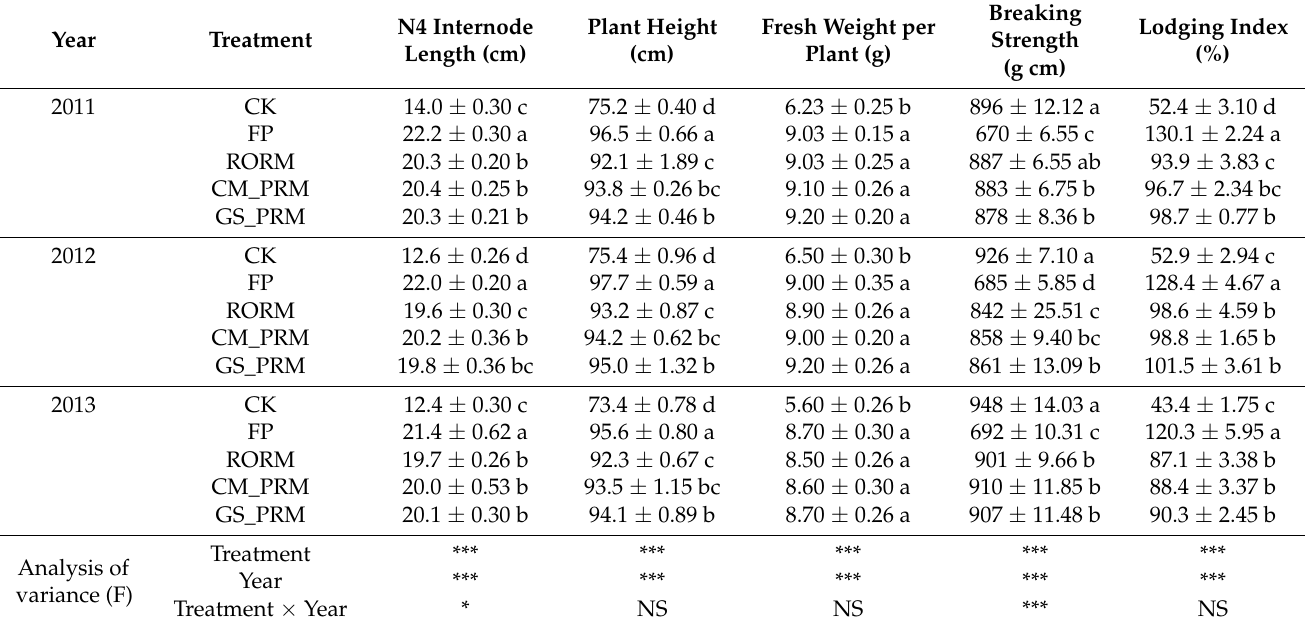
Table 4. Lodging resistance parameters (average values ± standard deviations) of different rice management systems for rice variety Longjing 21 from 2011 to